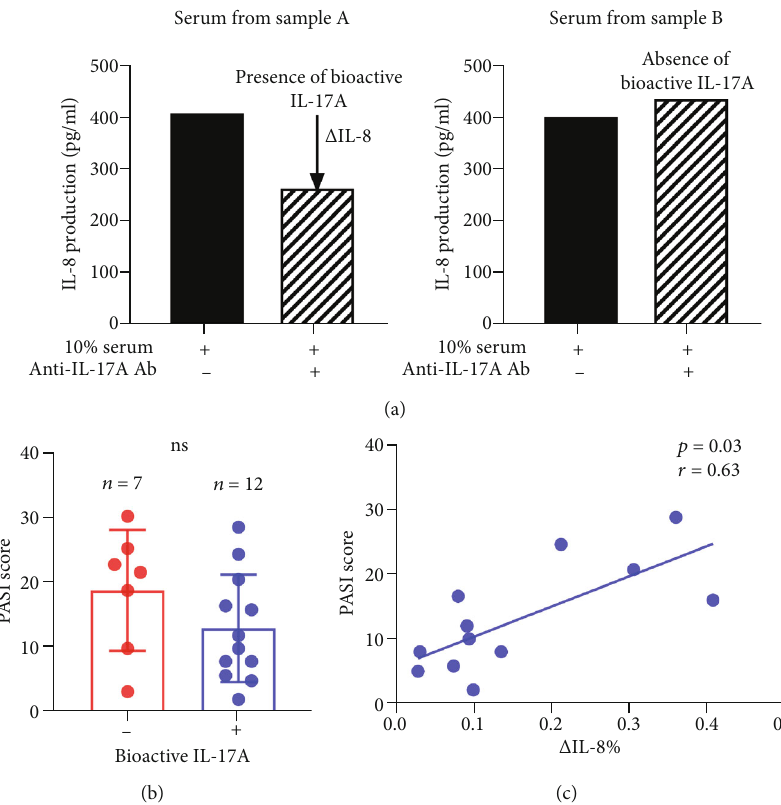
Figure 4: Bioactivities of serum IL-17A were correlated with psoriasis severity. (a) Primary keratinocytes (PKC) were cocultured with serum diluted in 10% in the presence and absence of anti-IL-17A antibodies. IL-8 in medium was measured by ELISA 24 hours later. (b) The comparison of the PASI score between patients with or without bioactive IL-17A in serum. (c) Correlation analysis between PASI score and the percentage of the decreased levels of IL-8 ( Δ IL-8) relative to those cultured with serum. Data are presented as mean ± SD and compared by the Mann – Whitney U test in (b) and Spearman ’ s correlation test in (c). ns: not signi fi